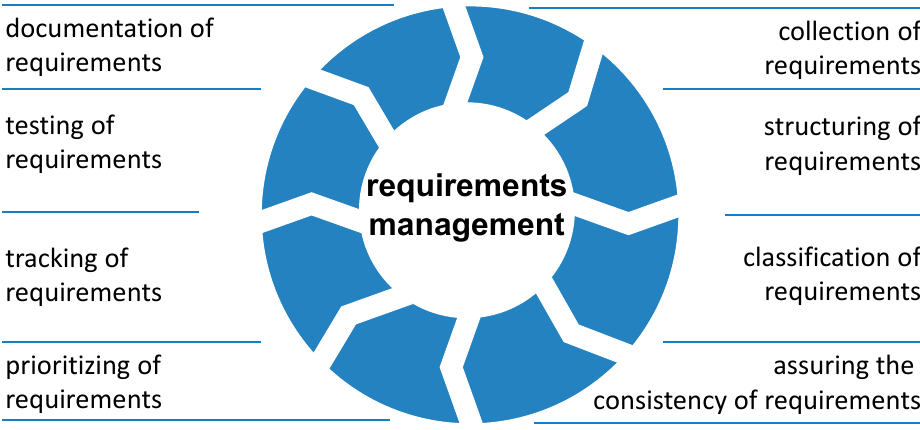
Figure 5. Stages in the requirements management process cycle.